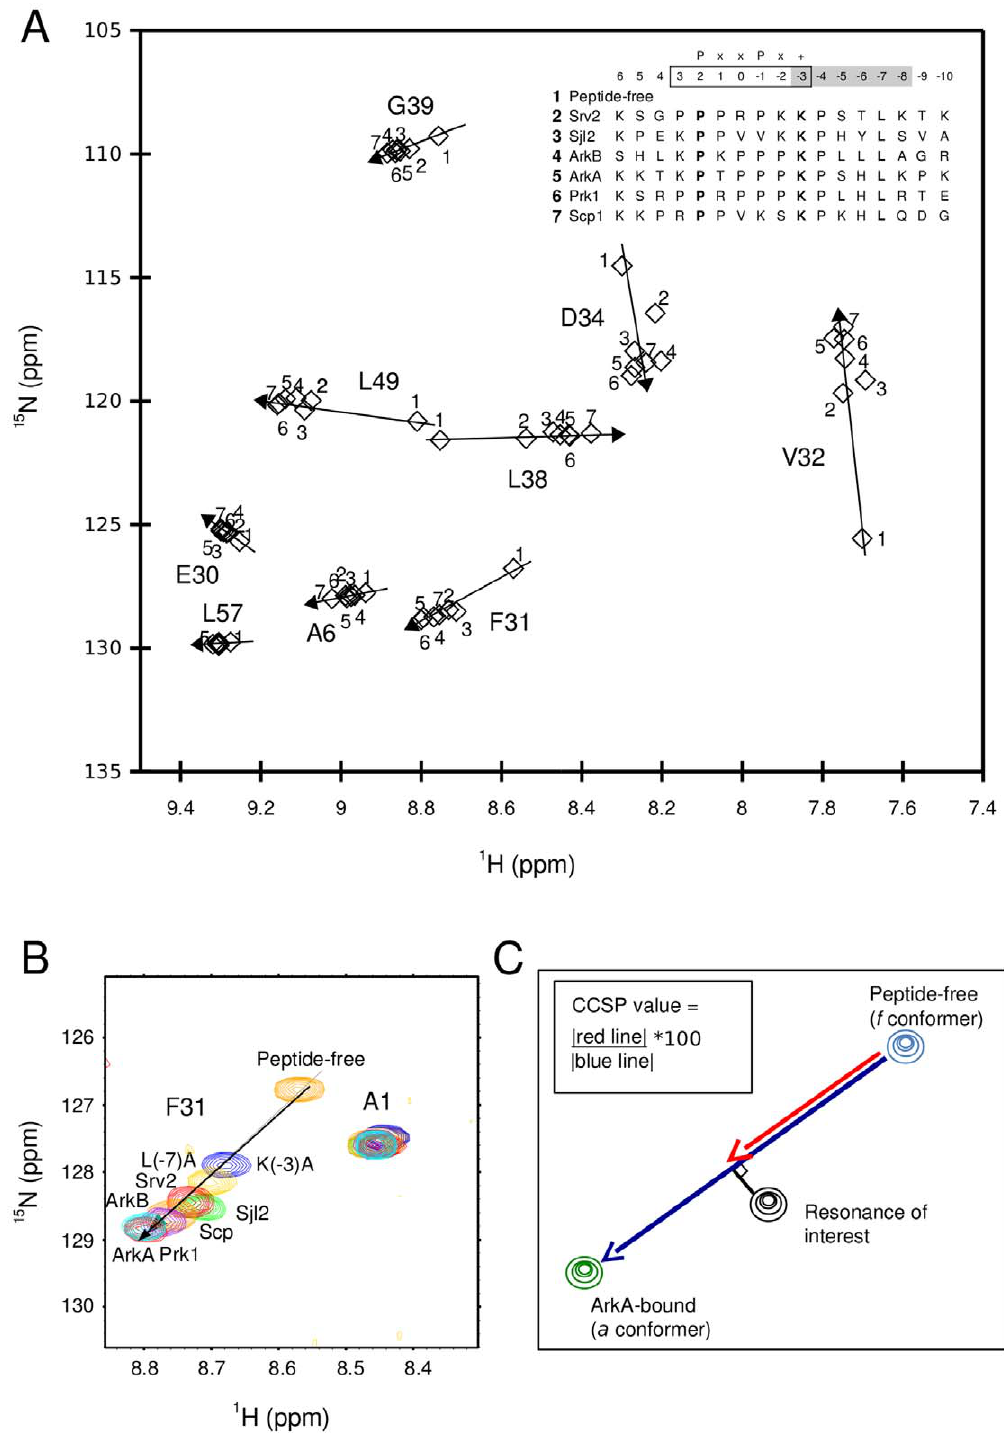
Figure 2. Co-linear chemical shift perturbation is found for 9 AbpSH3 residues in the initial set of 6 complexes. (A) Overlay of 7 NH correlation spectra (peak positions are represented by diamonds). Inset: an alignment of the AbpSH3 peptide targets, indicating the numbering system used for the peptides and the position of the PxxPx + motif for class II binding peptides, where P is a proline, x is any residue and + is a positively charged residue. Residues 3 to 2 3 are part of the SI binding region (box) and residues 2 3 to 2 8 are part of the SII binding region (shaded grey). The residues in bold are the three most energetically important residues for ArkA binding to AbpSH3. (B) An overlay of the F31 and A1 backbone NH resonance set from spectra of all complexes from (A) plus 2 ArkA mutant complexes. Peptide-free is orange, K( 2 3)A is blue, L( 2 7)A is gold, Sjl2 is green, Srv2 is red, Scp1 is orange, ArkB is purple, ArkA is cyan and Prk1 is red. (C) CCSP calculations for an example NH group found in free AbpSH3 (blue peak), AbpSH3 bound to a variant peptide (black peak) and AbpSH3 bound to ArkA (green peak). The CCSP value for the resonance found in the complex between AbpSH3 and the variant peptide is calculated by dividing the length of the red line into the blue line (CCSP line). The black line is the perpendicular distance of the resonance to the CCSP line and is used to assess how close it is to the CCSP line.